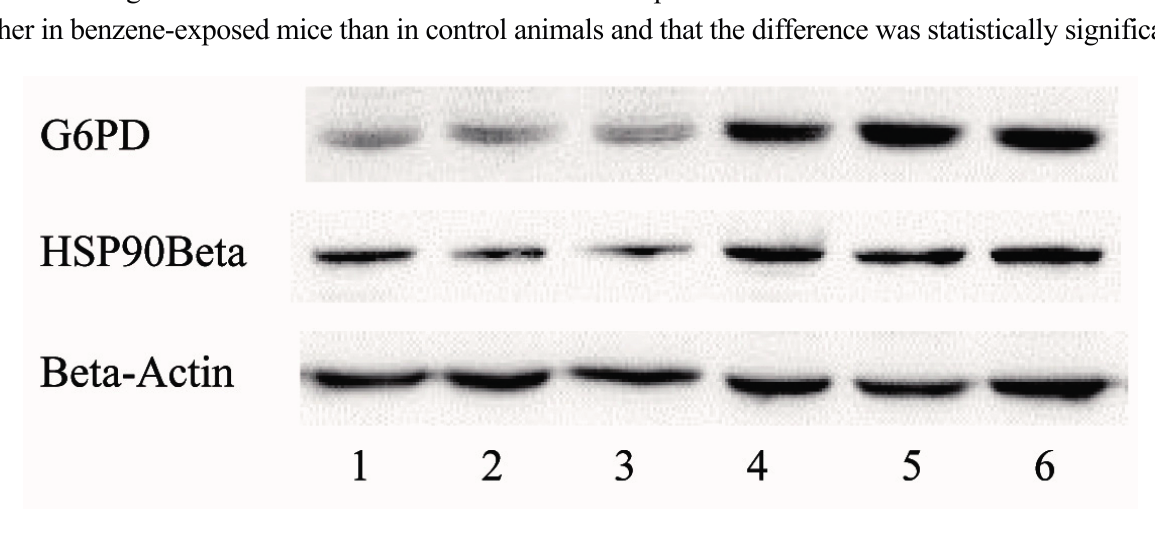
Figure 3. Expression of G6PD and HSP90 Beta in live cells of control mice and benzene-exposed mice; lanes 1, 2 and 3 show extracts from normal control mice and 4, 5, and 6 from 150 mg/kg benzene-exposed mice.